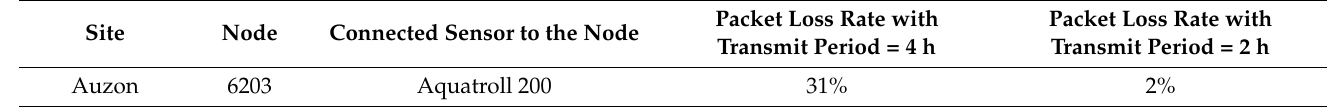
Table 5. Comparison of packet loss rate vs. transmit period